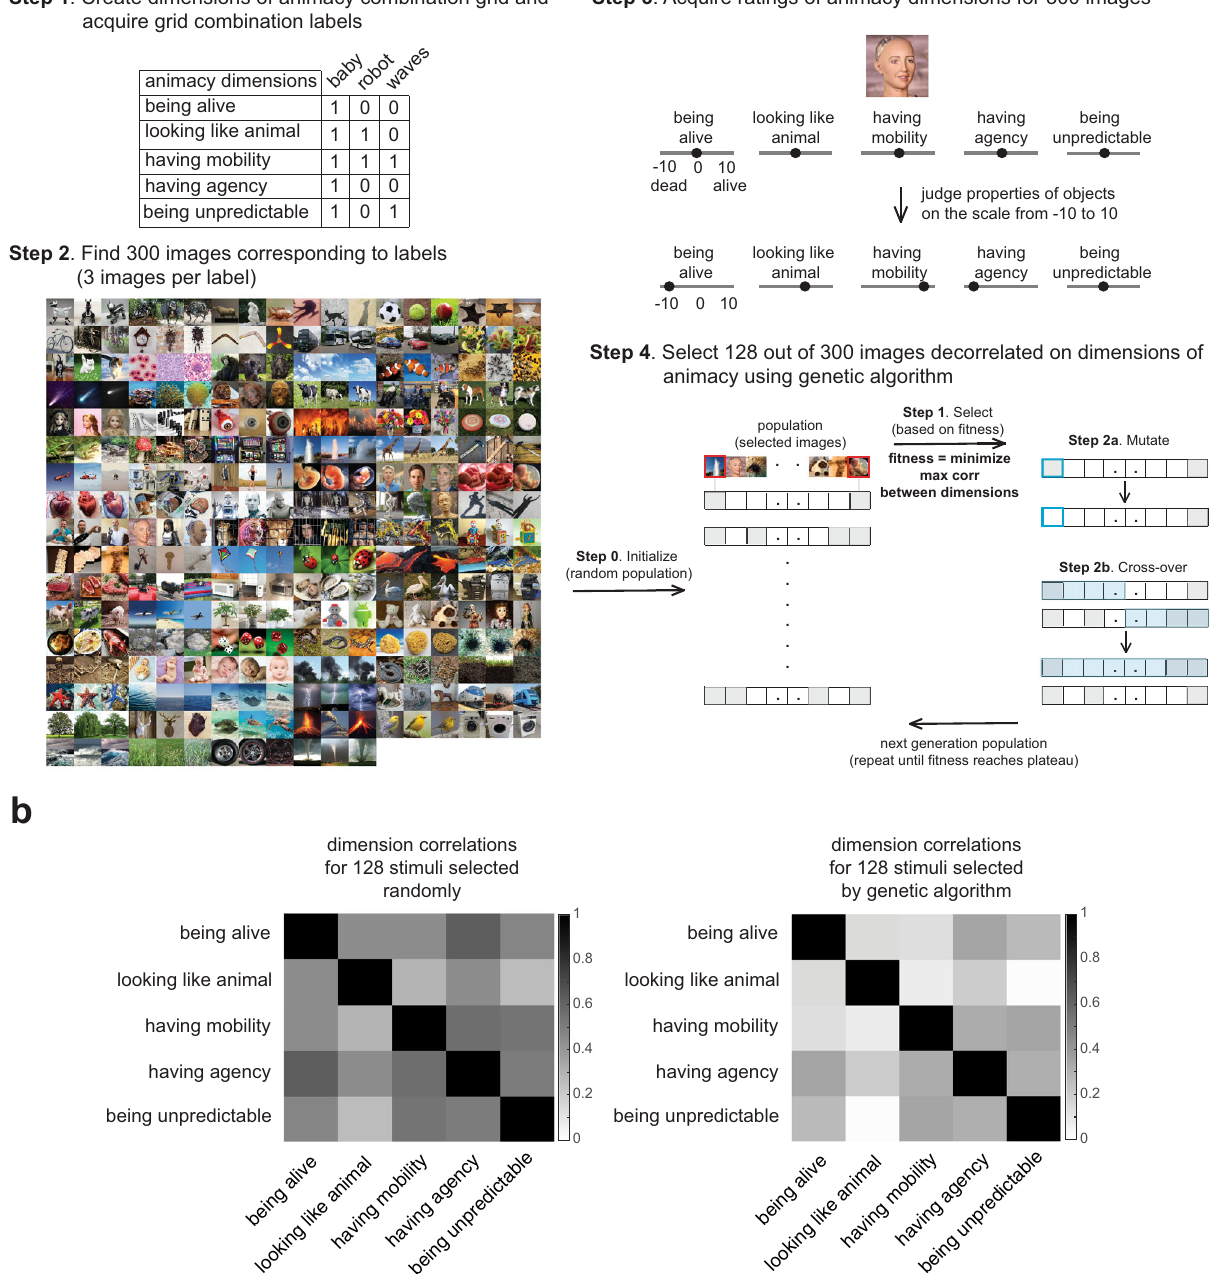
Fig. 1 Stimulus-selection procedure and pairwise correlation between animacy dimensions before and after stimulus selection by the genetic algorithm. a First, we created an animacy grid with all dimensions of animacy combinations and asked 11 participants to fi ll in the names of objects that ful fi lled these combinations. Second, we assembled object images based on object names from step one. Third, an independent set of 26 participants performed animacy ratings of 300 of these object images. Finally, we selected an optimal set of stimuli that had a low correlation between dimensions (as behaviourally rated) using a genetic algorithm. These stimuli were used in behavioural and brain representation experiments where a new set of participants was recruited to make sure that the stimulus generation and the actual experiments were independent. b Pairwise correlation between animacy dimensions for the randomly selected 128 stimuli (left) and the 128 stimuli selected by the genetic algorithm (right) in behavioural of the images representing object names from the initial 100 object names listed in step 1, as the dimensions of animacy ratings on these images were not optimal for the GA objective. The GA was allowed to choose a maximum of two different images representing different objects from a given category (e.g., two different animal robots) if this selection contributed to an